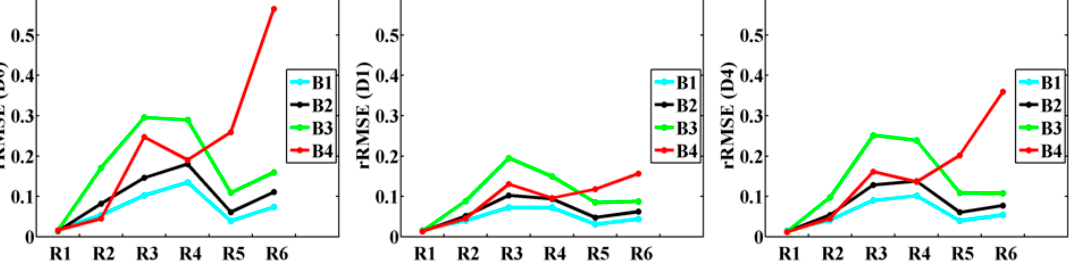
Figure 8. rRMSE values of bands 1–4 of cases U-D0, B-D1 and B-D4 across six tested regions, with B1-B4 corresponding bands, R1 desert, R2 sparse agricultural, R3 dense farmland, R4 urban area, R5 braided river and R6 coastal area.